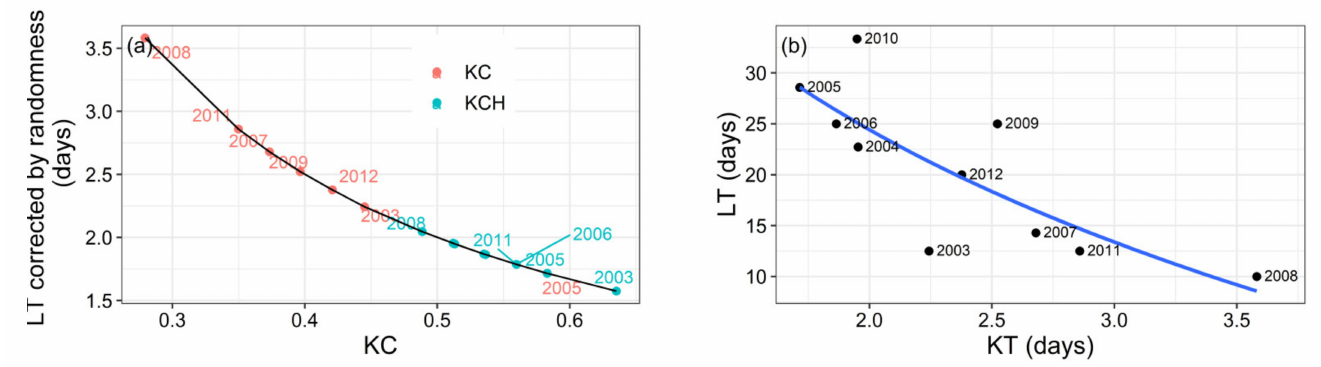
Figure 11. ( a ) Predictability of the daily H er data in Novi Sad given by the Lyapunov time (LT, in days) corrected by randomness versus Kolmogorov complexity (KC), and ( b ) LT versus Kolmogorov time (KT, in